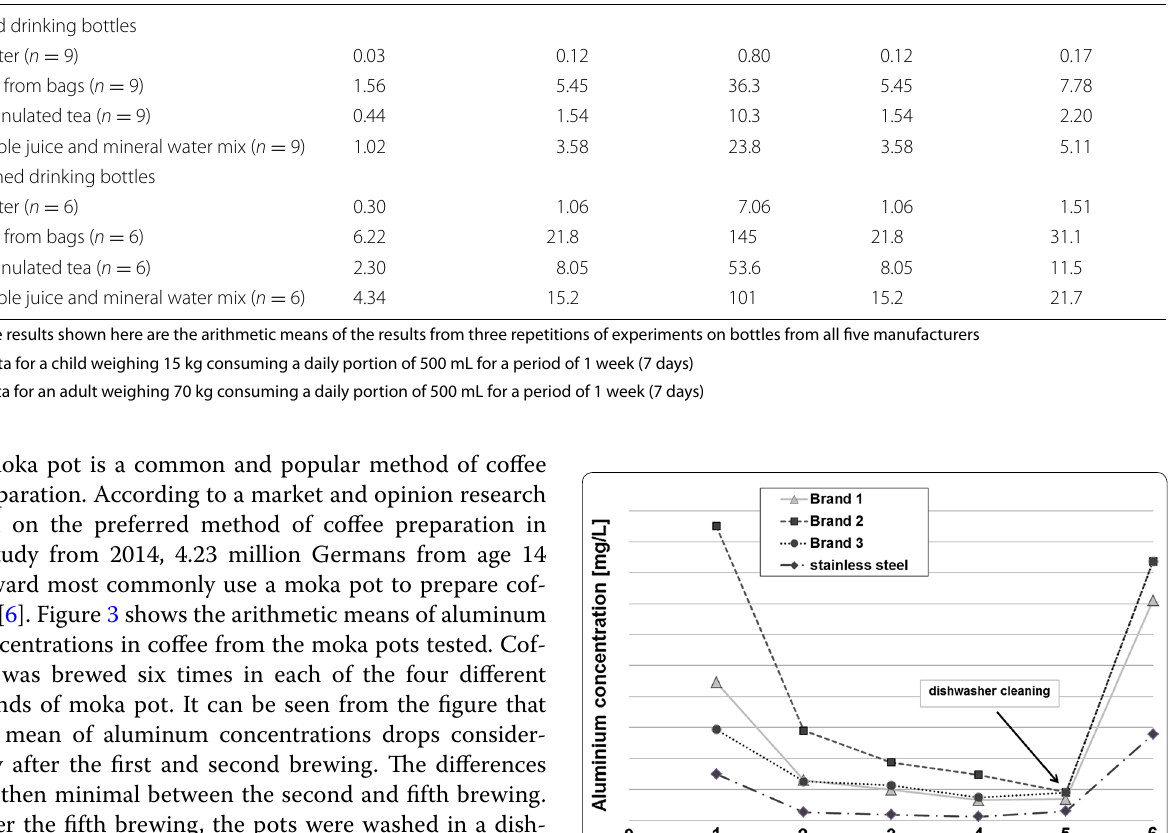
Table 1 Aluminum uptake from drinking bottles-child/adult and the respective percentage to TWI